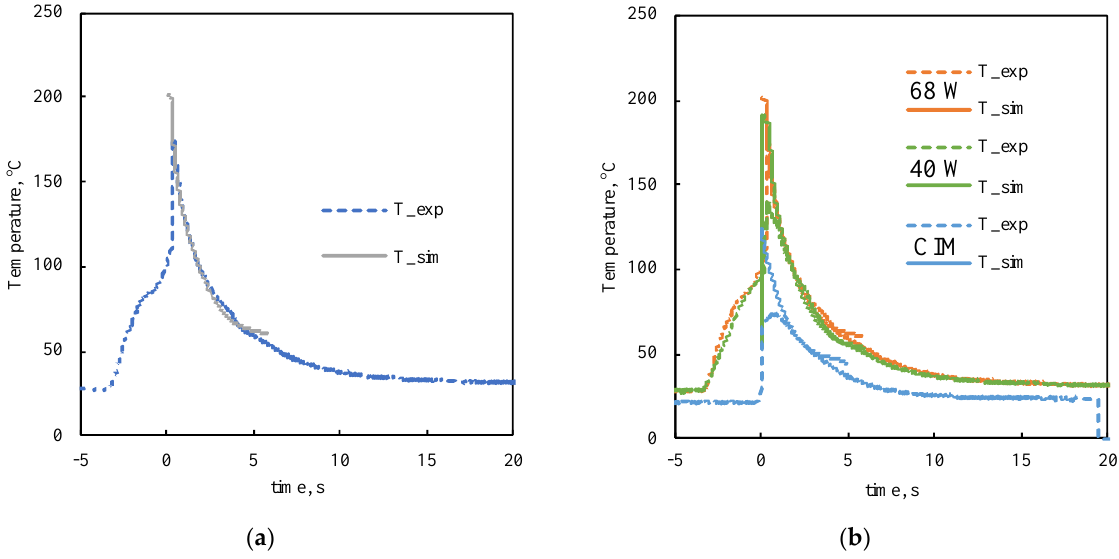
Figure 6. ( a ) Temperature evolution recorded on the cavity surface at position P2 for the case with a 68 W heating power. ( b ) Comparison with the simulated temperature evolution in the same position.